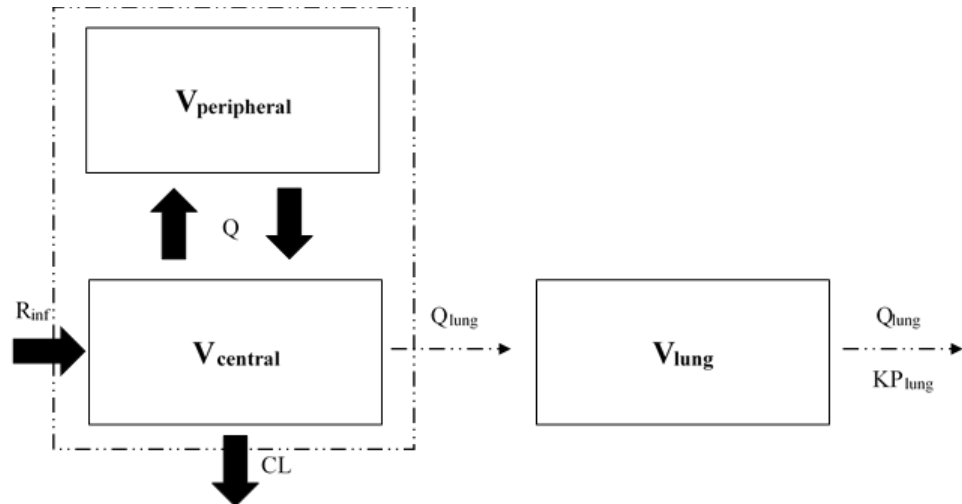
Figure 4. Pulmonary PK modeling of ampicillin and sulbactam.Model parameters: V central and V peripheral , volumes of distribution of the central and peripheral compartments (L), respectively; V lung , lung volume (kg); CL, clearance (L/h); Q, central – peripheral intercompartmental clearance (L/h); Q lung , lung plasma flow (L/h); KP lung , lung-to-plasma partition coefficient; R inf , rate of infusion (mg/h).